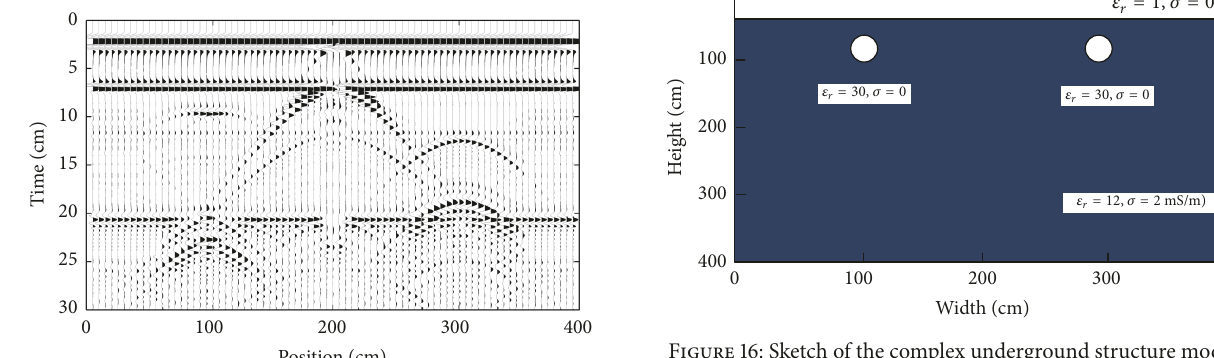
Figure 16: Sketch of the complex underground structure model. method by using conformal and nonconformal modeling method for two cavities, respectively. As shown in Figure 16, this model included an air-earth interface and a soil layer with two cavities with a radius of 5 cm. The model size and dielectric parameters were shown in Figure 16. The excitation source was the same as the second model. The time step and spatial interval increment were selected as dt = 0.01 ns and Δ x = Δ y = dl = 0.5 cm, respectively. We placed receivers and transmitters along the air-earth interface every 1 cm. The distance between the receiver and transmitter was 10 cm. Figures 17 and 18 were GPR sim- ulation section using CUDA-implemented FDTD